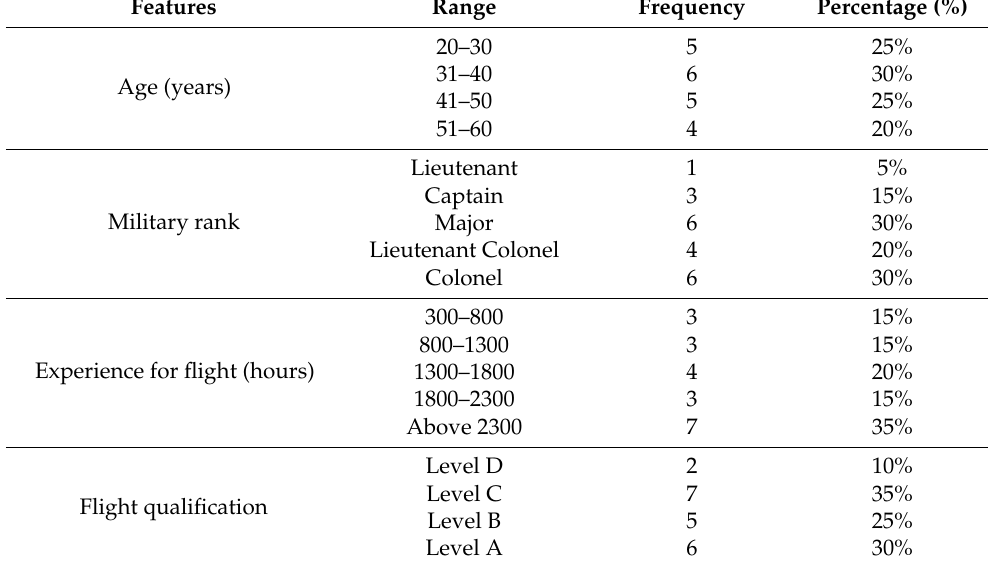
Table 3. Profile of the